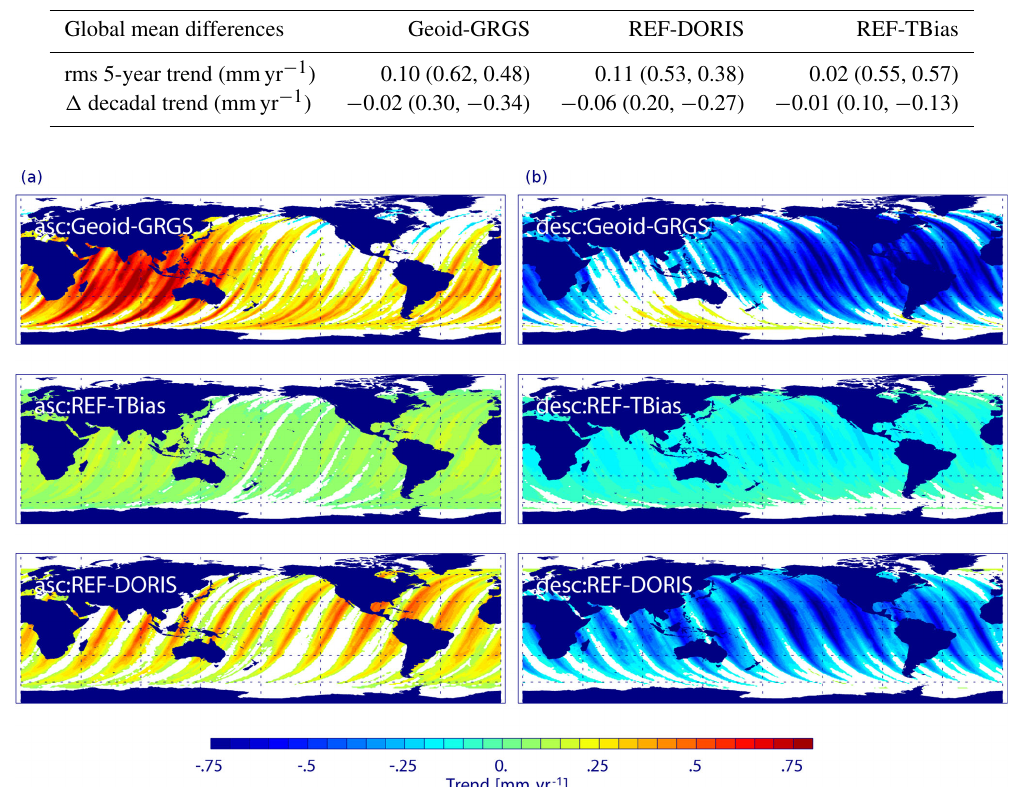
Figure 8. Decadal trend differences of radial orbit components for ascending (a) and descending (b) passes for Geoid minus GRGS, REF minus TBias, and REF minus DORIS for the period April 1993–June 2004. Regions with formal errors larger than the fitted value are masked out (white). The global mean trend difference over the ocean is given in Table